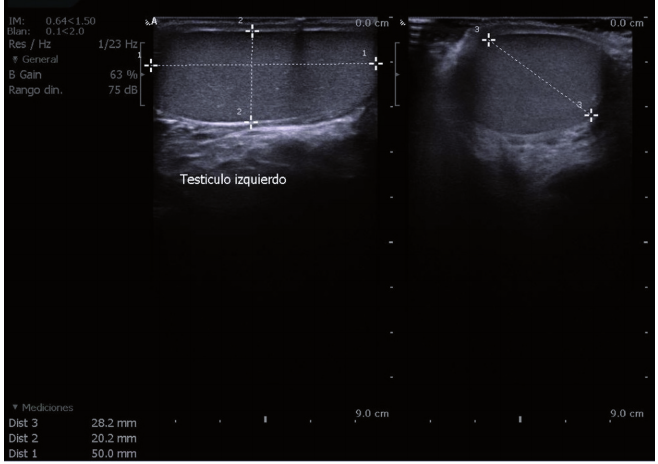
Figure 3 - Ultrasound image one year after surgery. Right testis preserves a normal volume (14.8cc) and